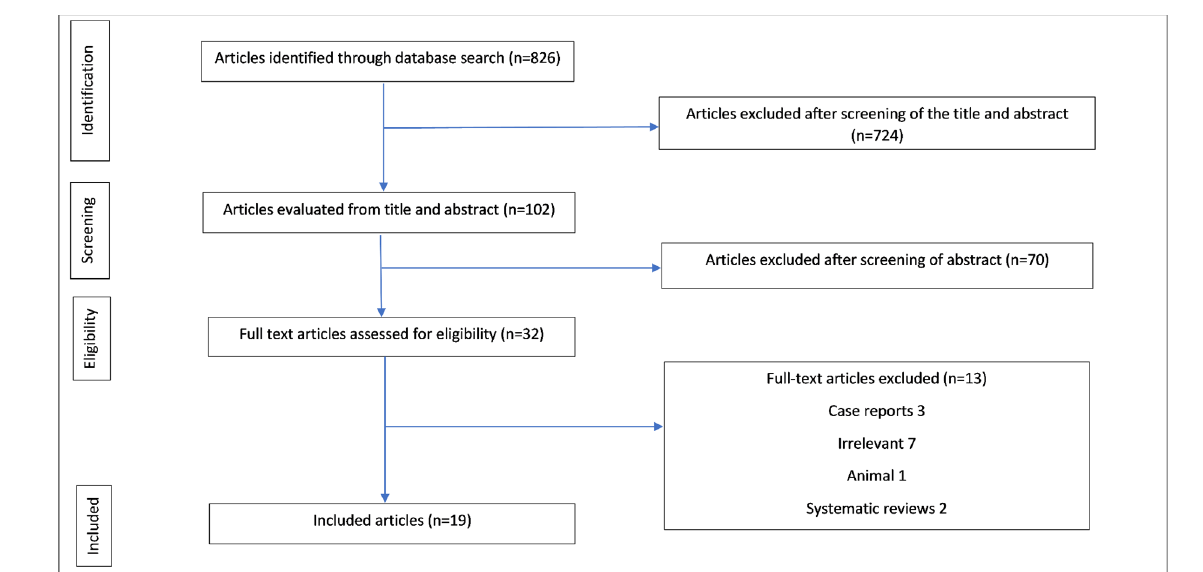
Figure 1. Diagram showing the PRISMA flowchart of studies searched, reviewed, and included in the systematic review. Table 1. Characteristics of studies on the use of intravesical aminoglycoside for UTI.